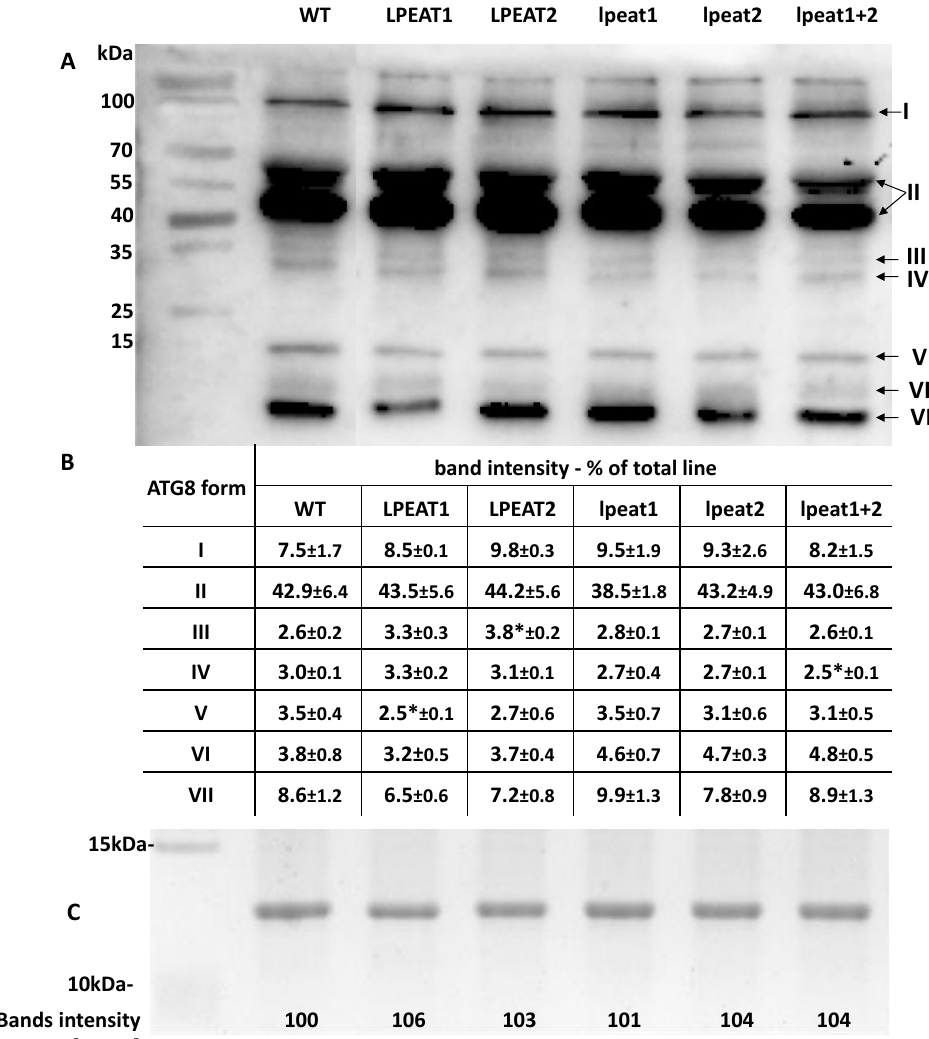
Figure 8. Relative amount of different form of ATG8 proteins in total protein extracts from leaves (0 DAF) of wild-type Arabidopsis plants (Col-0) and LPEAT1 and LPEAT2 overexpressors, lpeat1 and lpeat2 single mutants and lpeat1 lpeat2 double mutant grown in soil under standard conditions. ( A ) Selected western blot analysis on urea gel; equal amounts of protein (10 µg) were loaded and separated on the urea gel. The blots were incubated with polyclonal antibodies (anti-APG8a/ATG8a (abcam)) against ATG8 protein. ( B ) Bands intensity determined by “Image Lab 6.01” program. Means ± SD are presented ( n = 3). Asterisk indicates significant difference compared with WT in “mean difference two sided test” at α = 0.05. ( C ) Fragment of selected gel with stained protein bands localized between 15 and 10 kDa and “Image Lab 6.01” analyses of the intensity of these bonds.